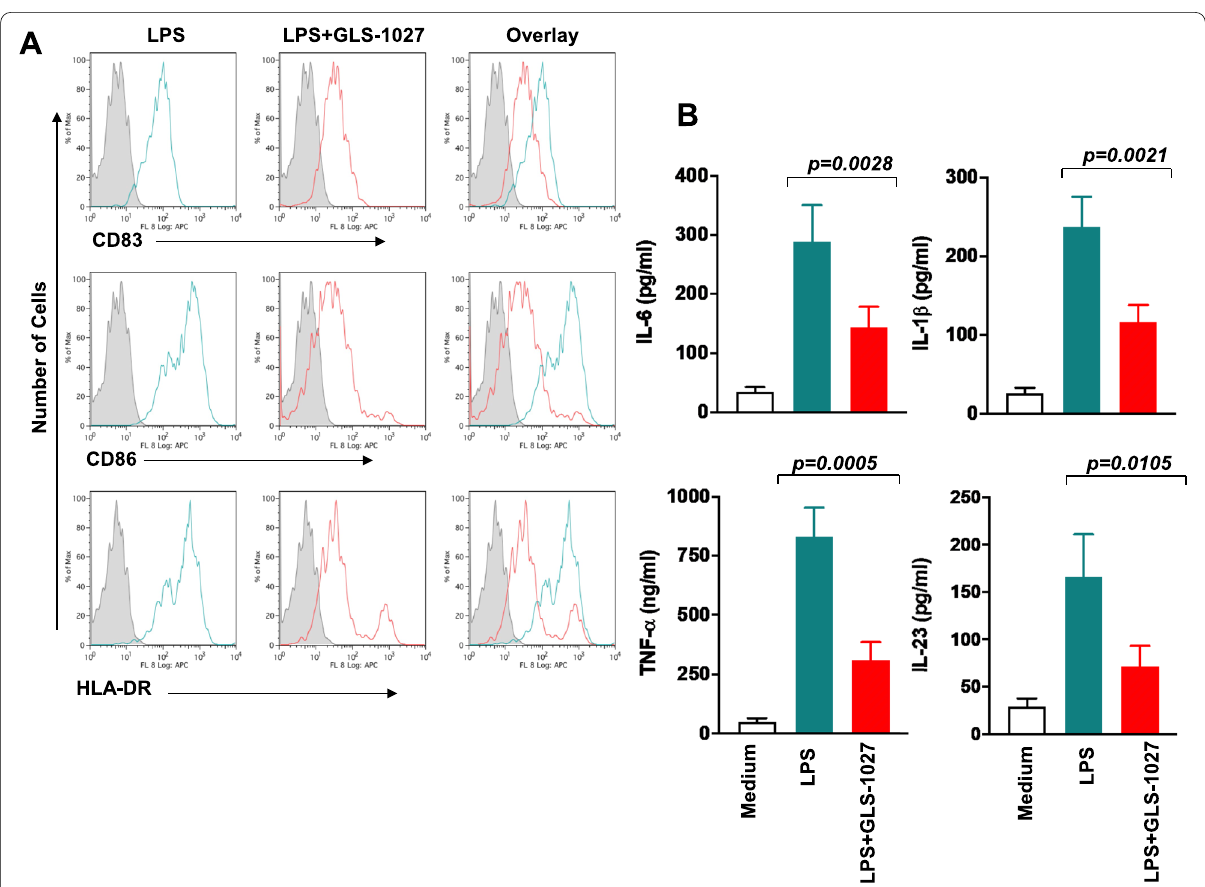
Fig. 3 Effect of GLS-1027 on DC’s differentiation and maturation. ( A ) Fresh human monocytes were allowed to attach to cell culture plates as described in Materials and Methods and stimulated with GM-CSF/IL-4 for 6 days were allowed to adhere in the absence or presence of GLS-1027 (10µM) for 7 days to develop into dendritic cells. On day 7, the cells were harvested, and were stained with indicated mAbs and analyzed by flow cytometry. Histograms show the staining of specific surface markers, and filled grey histograms represent the isotype-matched control antibody staining, blue line is LPS treatment, and red line is LPS GLS-1027 treatment. The results are representative of two independent experiments. ( B ) + GLS-1027 inhibits LPS-induced cytokine production of DCs. On day 7 cell culture supernatants from DCs cultured with LPS in the presence of GLS-1027 were measured via ELISA for the concentrations of the cytokines TNF-α, IL-1β, IL-6 and IL-23 in the media. A non-parametric two-tailed t- test (Mann–Whitney) was used for statistical analysis, and the relevant p values are indicated. Error bars in all panels indicate 1 standard deviation among 3 replicates per condition. The experiment was repeated twice with similar results are